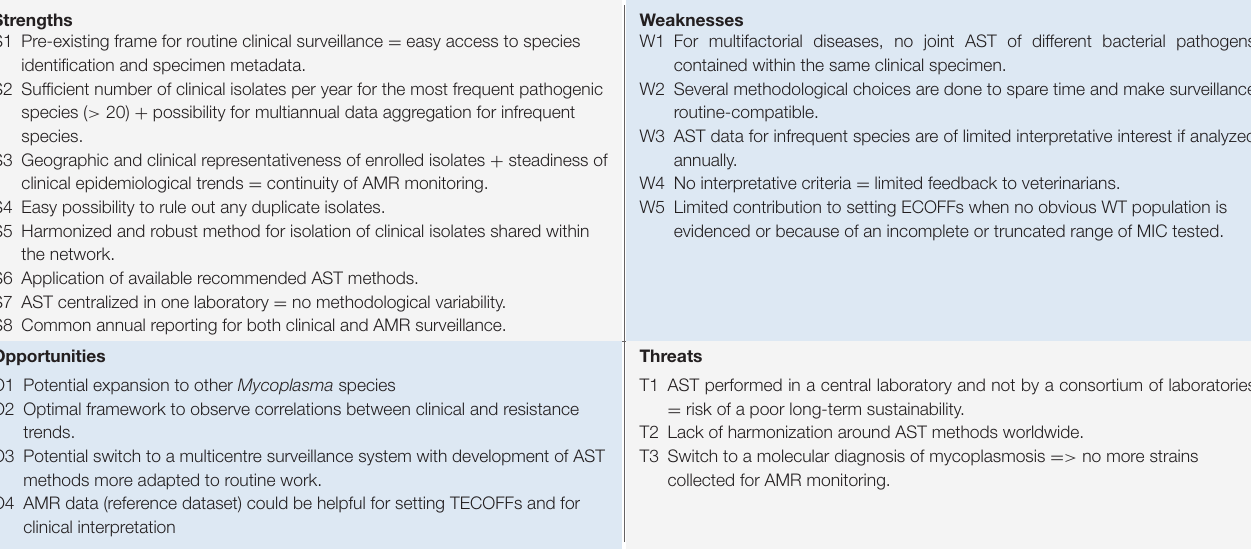
TABLE 4 | SWOT analysis of AMR surveillance performed through Vigimyc over the 2018-2019 period.